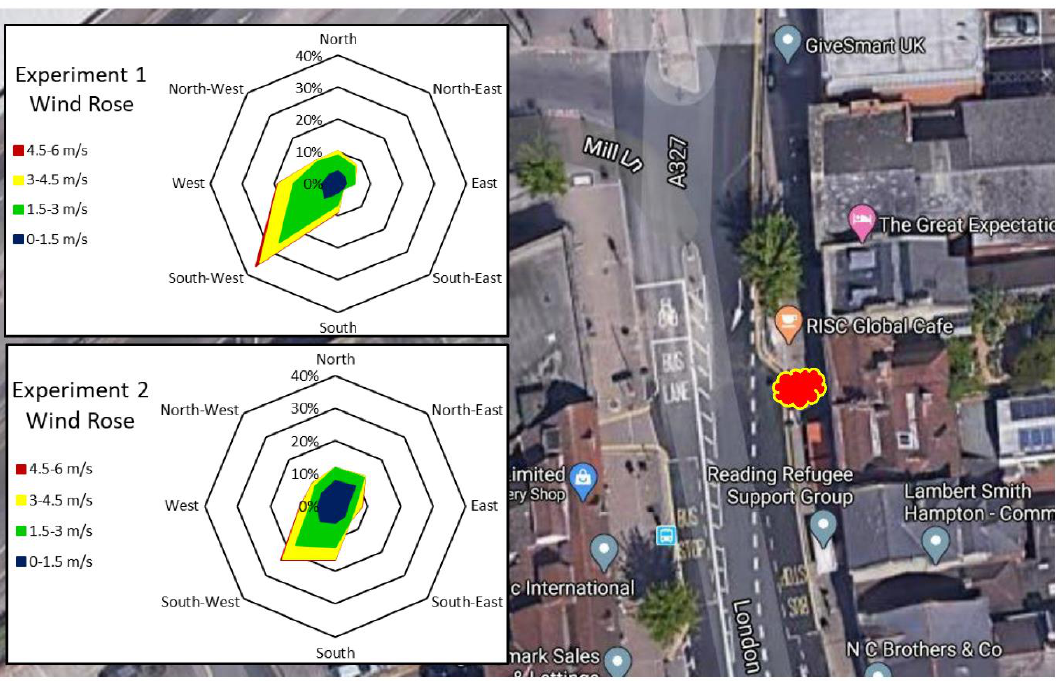
Figure 2. Location of sampling site on a major road used for Experiments 1 and 2, and corresponding wind roses indicating prevailing wind conditions a month prior to sampling. This site corresponds to red location marker 1 in Figure 1.